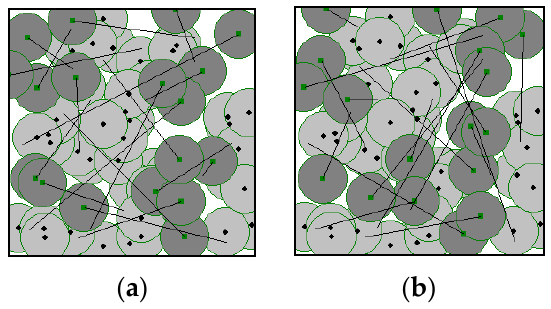
Figure 6. Mobile sensor node relocation results of ( a ) genetic algorithm (GA) in [24]; and ( b ) particle swarm optimization (PSO) in [25].